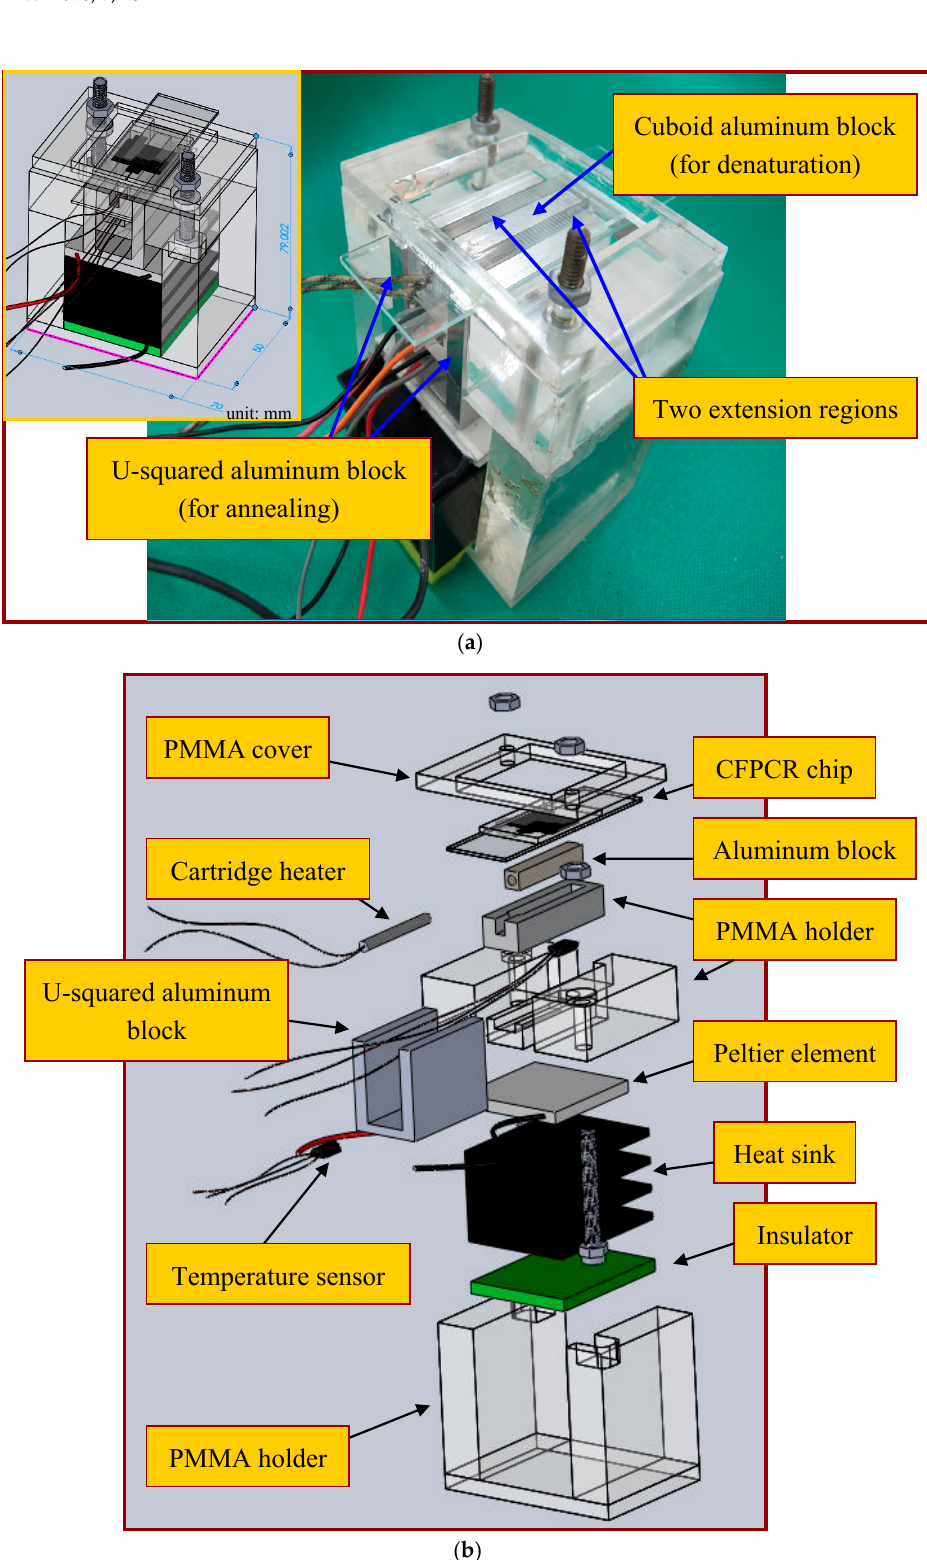
Figure 3. ( a ) The assembled CFPCR device; ( b ) an exploded view of the device.